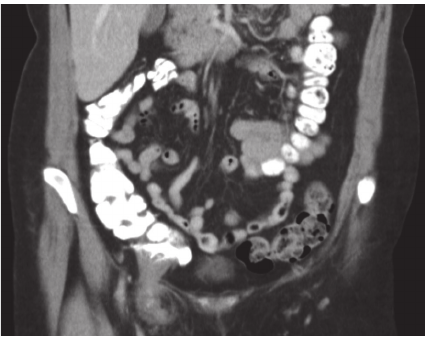
Figure 1: Preoperative abdominal CT image of the patient. Note the oral contrast in the colon, past the ileocaecal